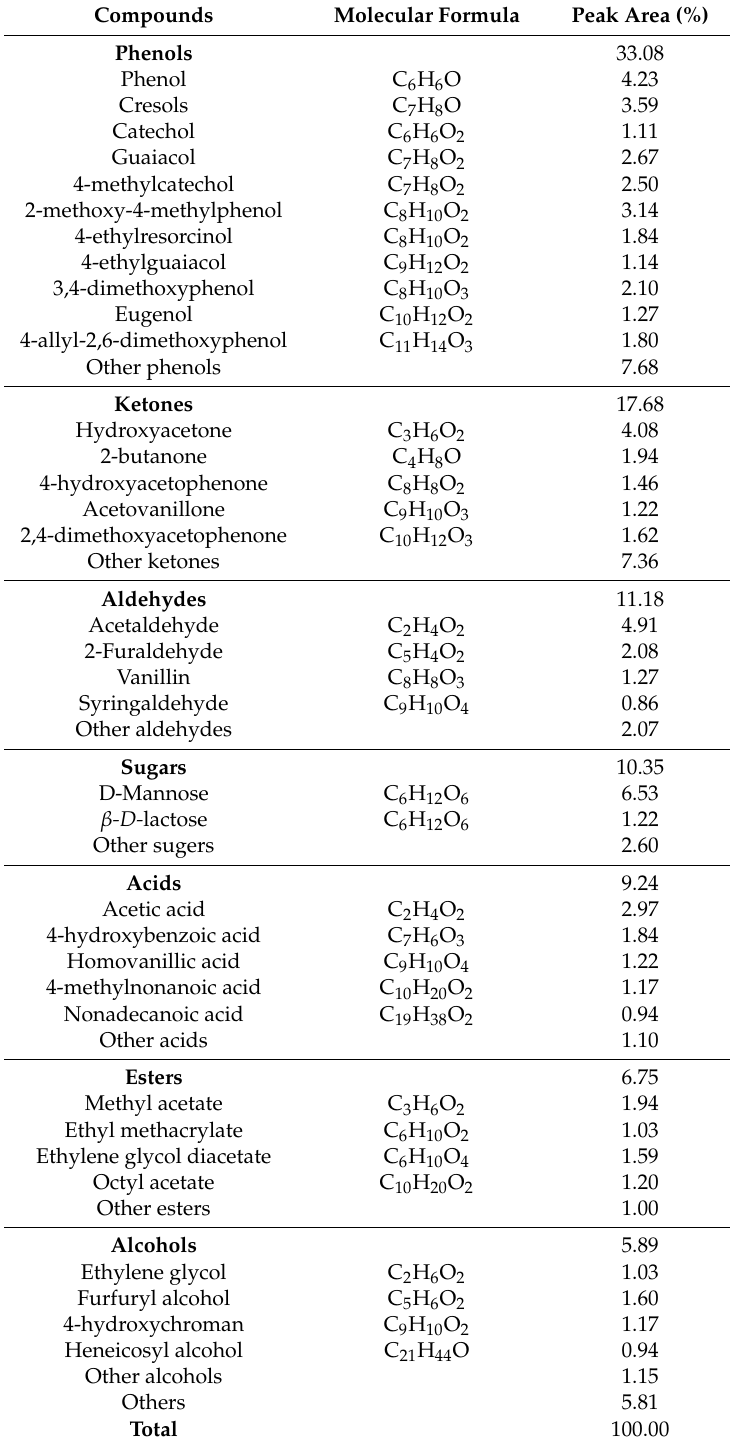
Identification and quantification of the main organic components in bio-oil by gas chromatographic-mass spectrometry